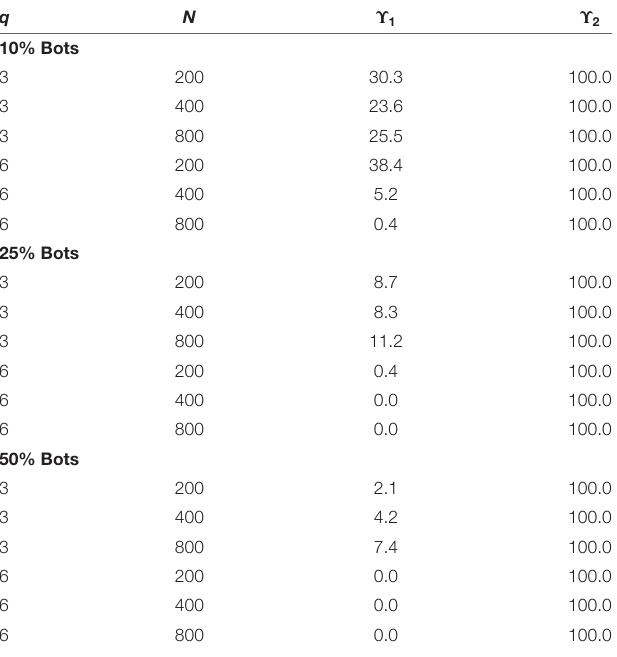
TABLE 4 | Percent significant results for ϒ 1 (person-fit index) and ϒ 2 (variability index) in the latent class model of the LC-CFA based on the 95% Credible Interval across conditions of sample size ( N ), number of factors ( q ), and proportion of bots.